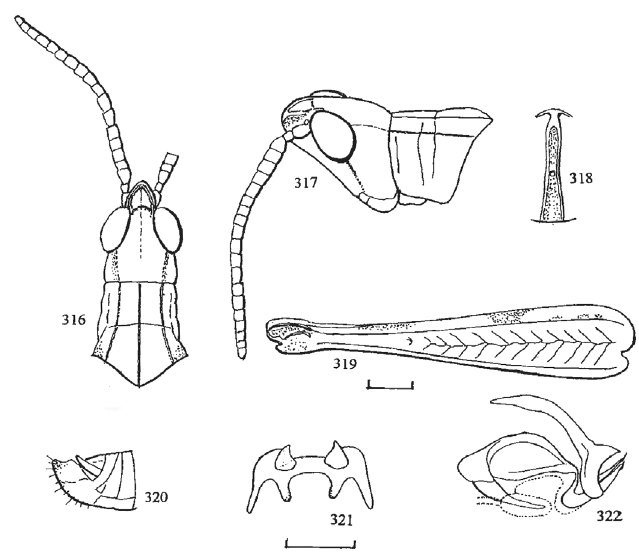
Figs 316–322. Tribe Gymnobothrini. Tenuihippus. Figs 316–322. Tenuihippus parvus male: 316. Dorsal view head, pronotum and antennae; 317. Idem oblique lateral view showing temporal fo- veolae; 318. Frontal ridge; 319. Hind femur, outer side; 320. Tip of male abdomen laterally; 321. Epiphallus; 322. Phallic complex without epiphallus from left side. Scale lines all 1 mm: that below Fig. 321 applies to Figs 321, 322; that under Fig. 319 applies to Figs 316–320.